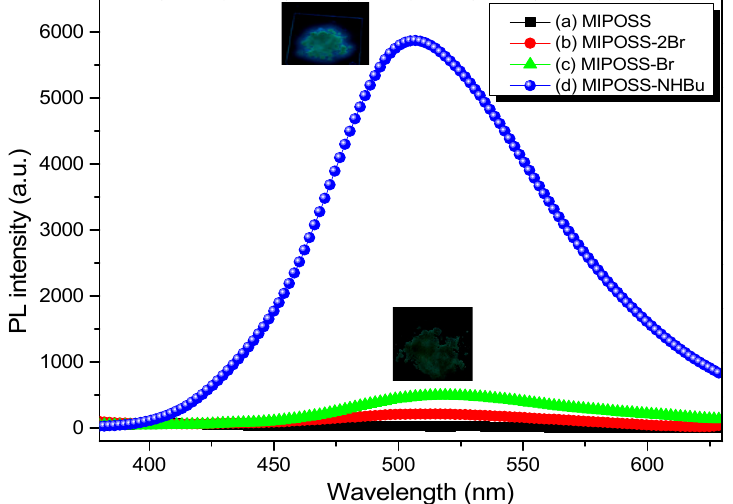
Figure 9. PL spectra of: ( a ) MIPOSS; ( b ) MIPOSS-2Br; ( c ) MIPOSS-Br; and ( d ) MIPOSS-NHBu, in the solid state (excitation: 330 nm). Top insert figure is photo image for MIPOSS-NHBu and the bottom insert figure is photo image for MIPOSS-Br under excitation at 330 nm.